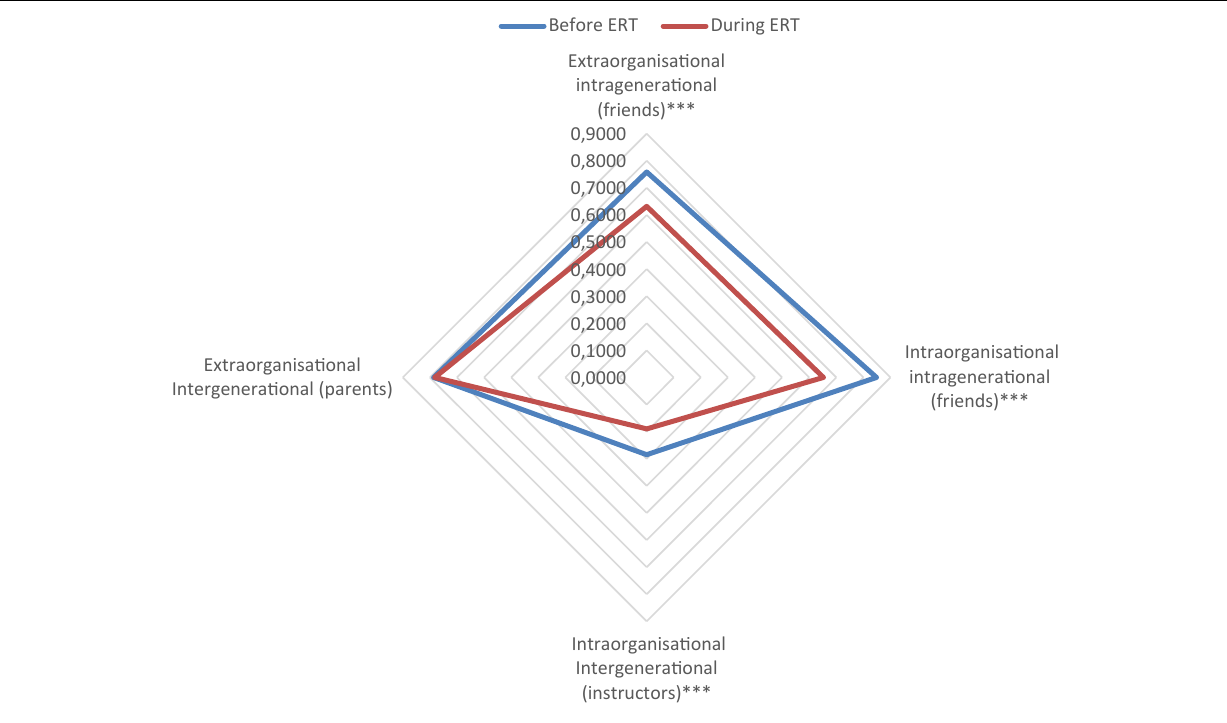
FIGURE 2 | Mean of the values of networks between 0 and 1. Source: Learning alone ( N = 677). Paired t-tests ∗ ≤ 0.05, ∗∗ ≤ 0.01, ∗∗∗ ≤